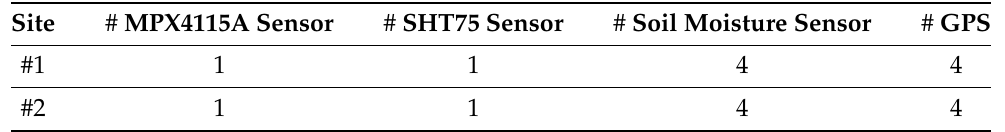
Table 2. Experimentation sites: Smart Framework